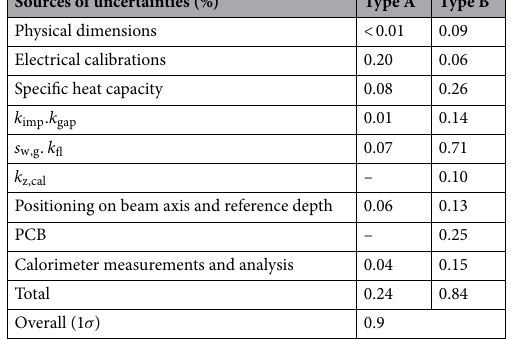
Sources of uncertainties